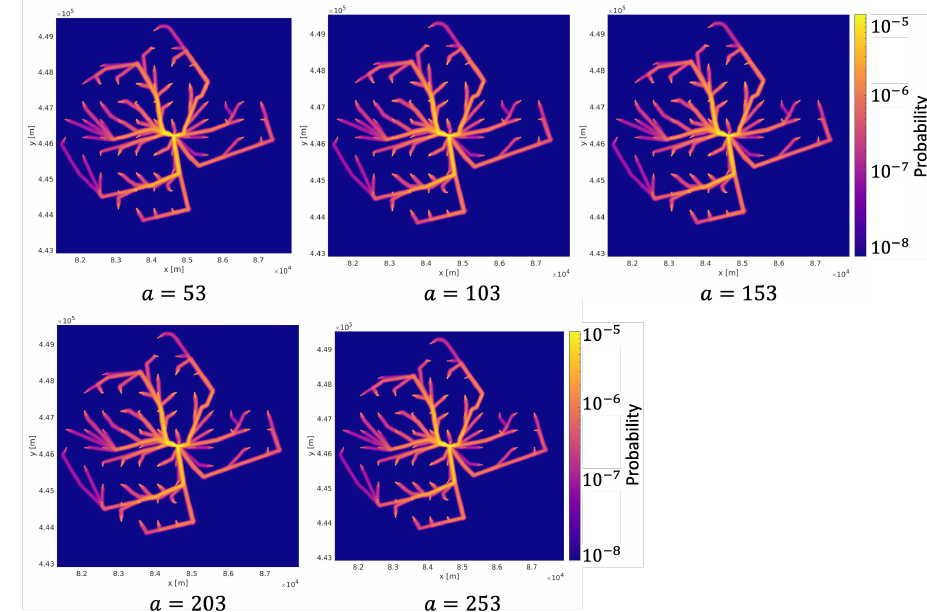
Figure A8. Annual IR with different a in fatality